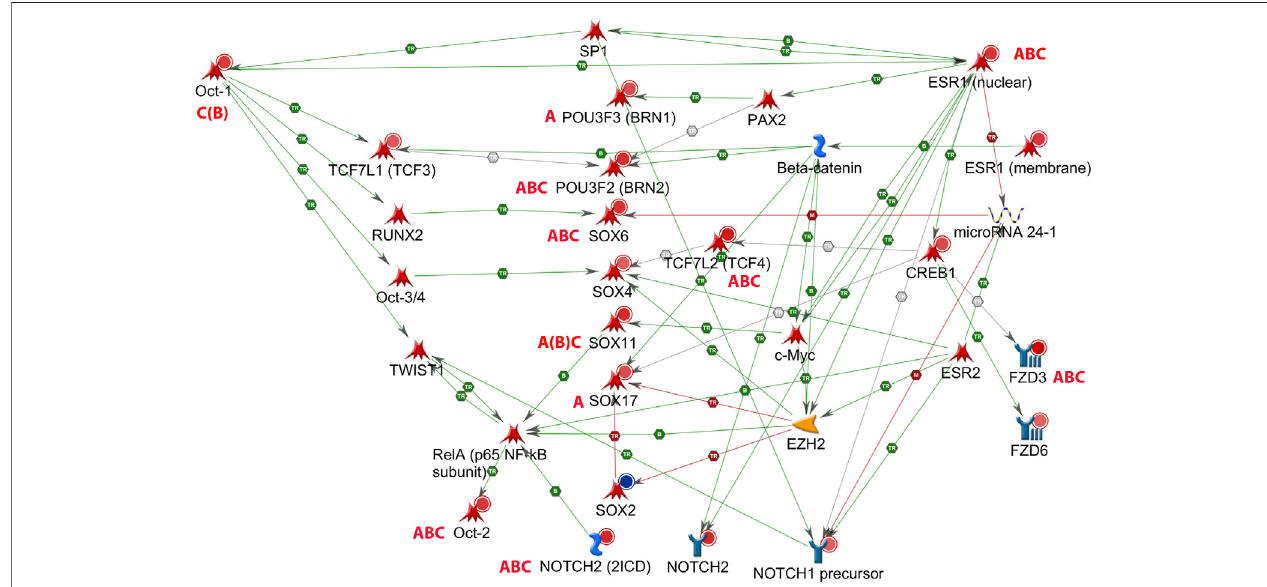
FIGURE 2 | Gene network of male rat hippocampus at postnatal day (PND) 6, with estrogen receptor alpha (Esr1). Up-regulation (red circles) or down-regulation (blue circle) of hippocampal genes exposed to Aroclor 1254 (5 mg/kg, A), bisphenol A (5 mg/kg, B), or chlorpyrifos (3 mg/kg, C) (see Table 4 ). Pou2f1/Oct1 and Sox11 exhibitedafalsediscoveryrate > 0.05afterbisphenolA,buttheeffectwascon fi rmedbyrealtimeRTPCR( Figure3 ).Literaturedataindicateapossibleinhibitoryactionof Esr1 on transcription of miR-24-3p, and of miR-24-3p on transcription of Sox6 (MetaCore, Shortest Paths network. TR: transcription, B: binding, M: miR binding, green: activation, red: inhibition).